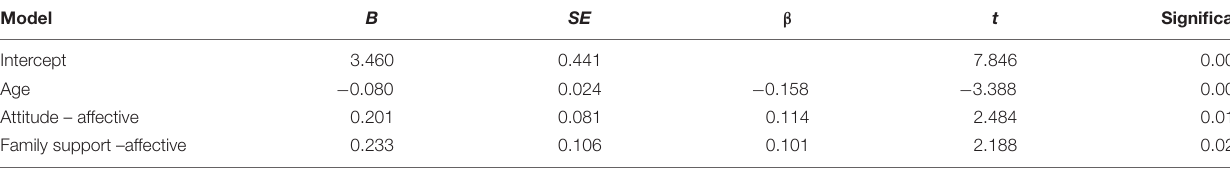
TABLE 3 | Summary of stepwise multiple regression analysis predicting girls’ PLC classifications. Model